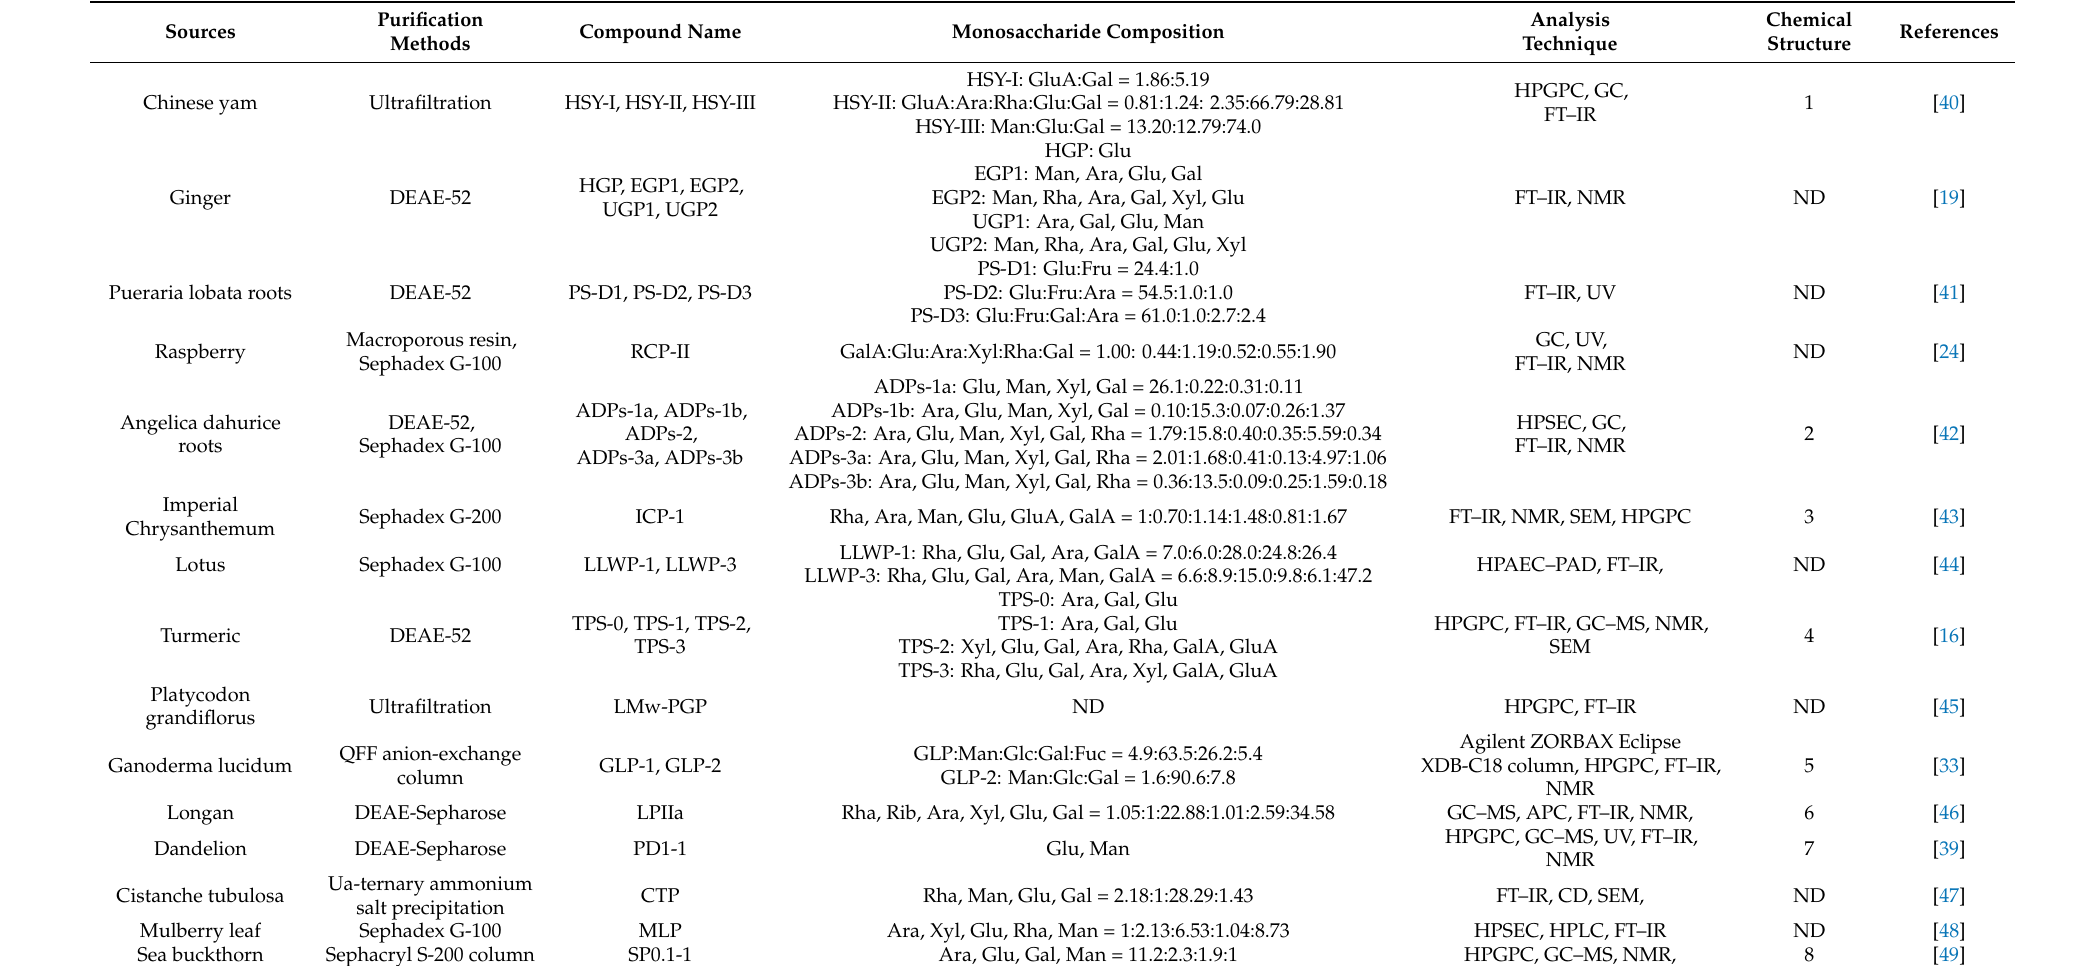
Table 2. Sources, purification methods, and structural features of